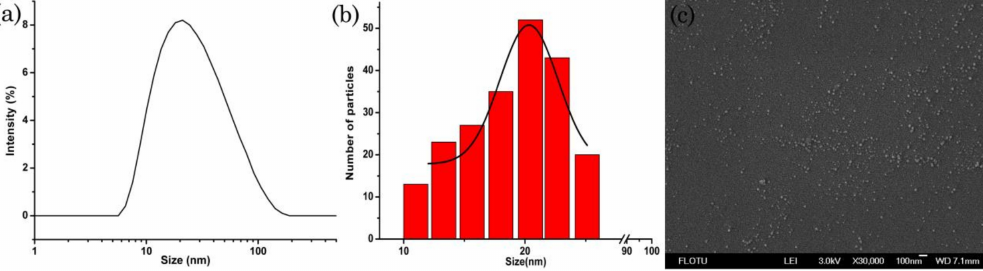
Figure 10. DLS and SEM characterization of the nanosuspension at 0 ◦ C for 7 days: ( a ) Particle size distribution based on DLS; ( b ) Particle size distribution based on SEM image; ( c ) SEM image of the lambda-cyhalothrin